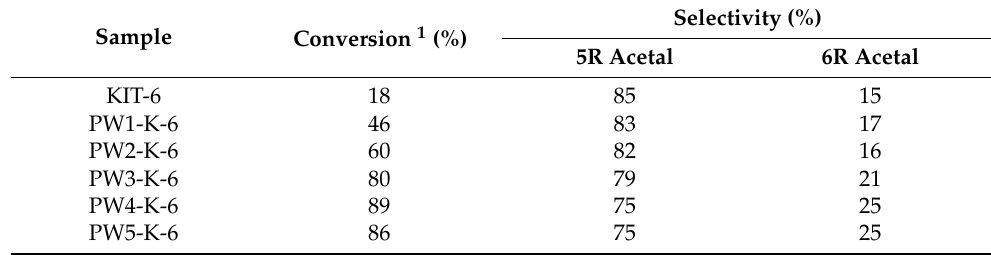
1 After 5 h of Table 2. Glycerol conversion and selectivity to five-member ring acetal and six-member ring ace- Figure tal.